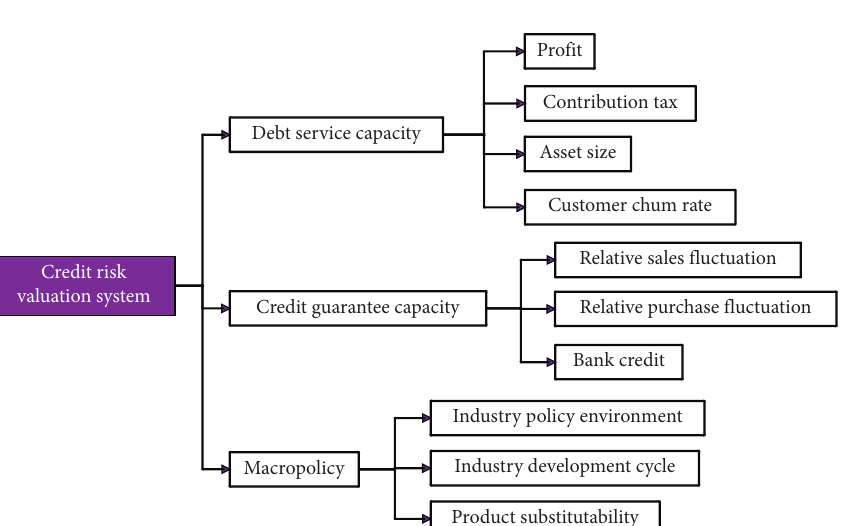
Figure 1: Corporate reputation risk evaluation index system.